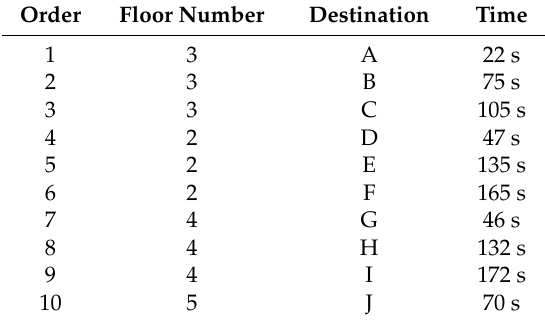
Figure 33. The positions of the moving object and locations of the search results. (The black humanoid is the location of the moving object, and ( A – J ) denote the 10-nearest lavatories to the moving object; ( A – C ) are located on the 3rd floor; ( D – F ) are on the 2nd floor; ( G – I ) are the 4th floor; and ( J ) is on the 5th floor.) Table 6. The actual arrival times of ITD-Tree and SI to the 10-nearest lavatories in the real dataset.